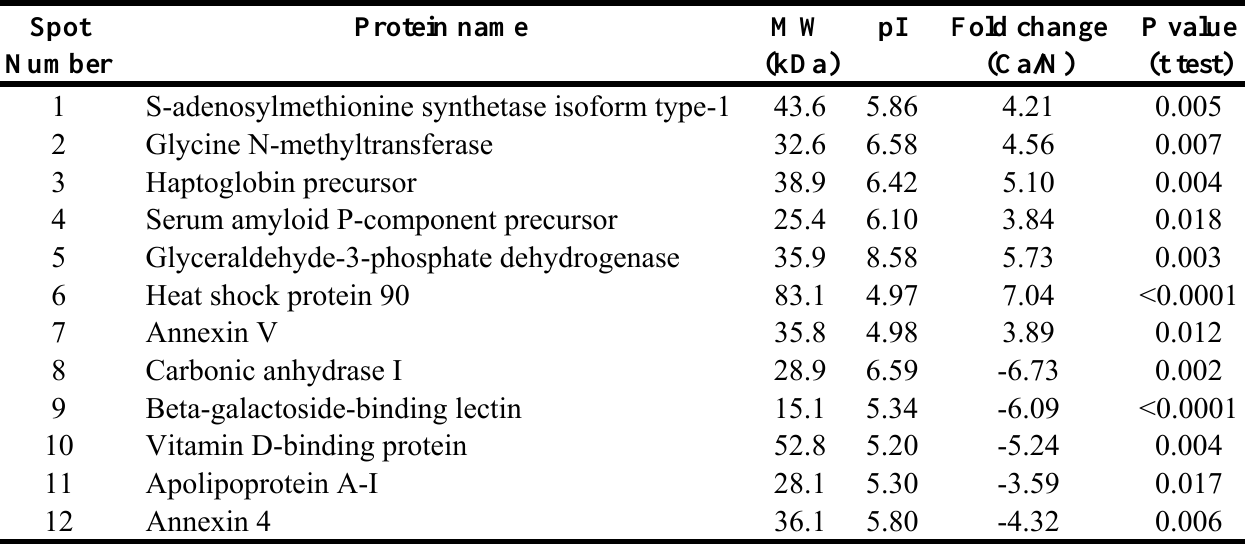
Table 1. Differentially expressed proteins identified by MALDI-TOF PMF in the serum of hepatocellular carcinoma and normal healthy controls.